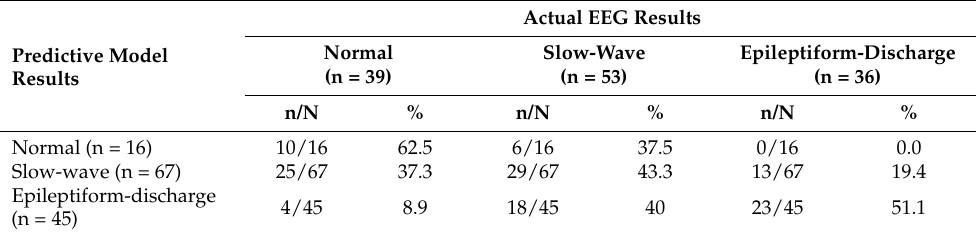
Table 4. Electroencephalography (EEG) classification with the predictive